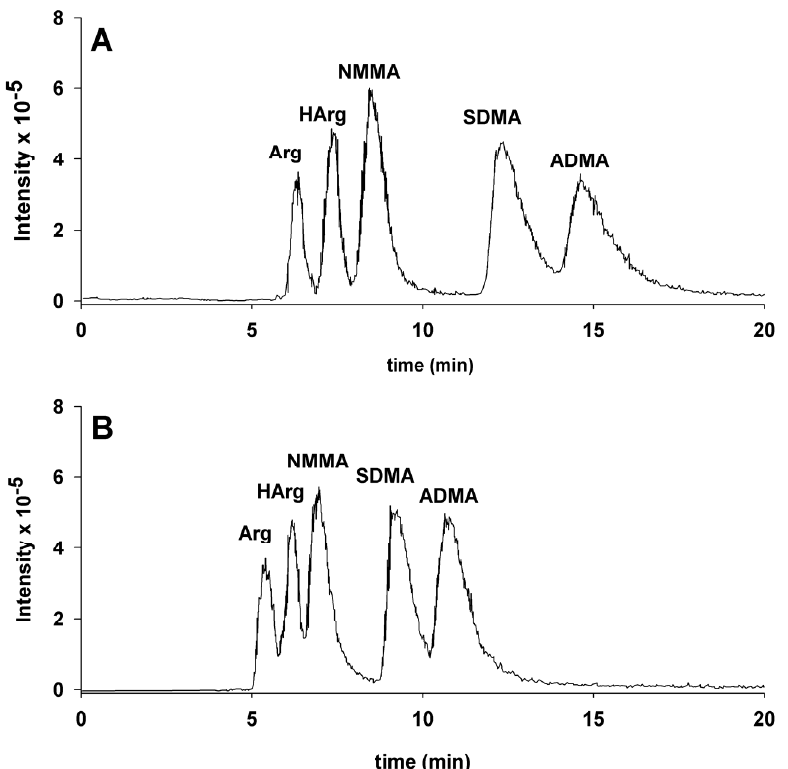
Figure 1. Chromatographic separation of Arg, HArg, NMMA, SDMA, ADMA with full-scan detection. ( A ) Elution pattern of the chromatography performed utilizing 10% of Sol. B (100 mM ammonium formate in water titrated to pH 4.5 with formic acid) and 90% Sol. A (0.1% formic acid in water); ( B ) Elution pattern of the chromatography performed utilizing 20% of Sol. B and 80% Sol. A. The concentrations were 5.1 µM for Arg, 5.9 µM for HArg, 7.4 µM for NMMA, 8.6 µM for SDMA and 8.4 µM for ADMA. The retention times for the chromatography in panel A resulted 6.3 min, 7.4 min, 8.4 min, 12.3 min and 14.6 min for Arg, HArg, NMMA, SDMA and ADMA, respectively. The retention times for the chromatography in panel B resulted 5.4 min, 6.1 min, 7.0 min, 9.1 min and 10.7 min for Arg, HArg, NMMA, SDMA and ADMA,